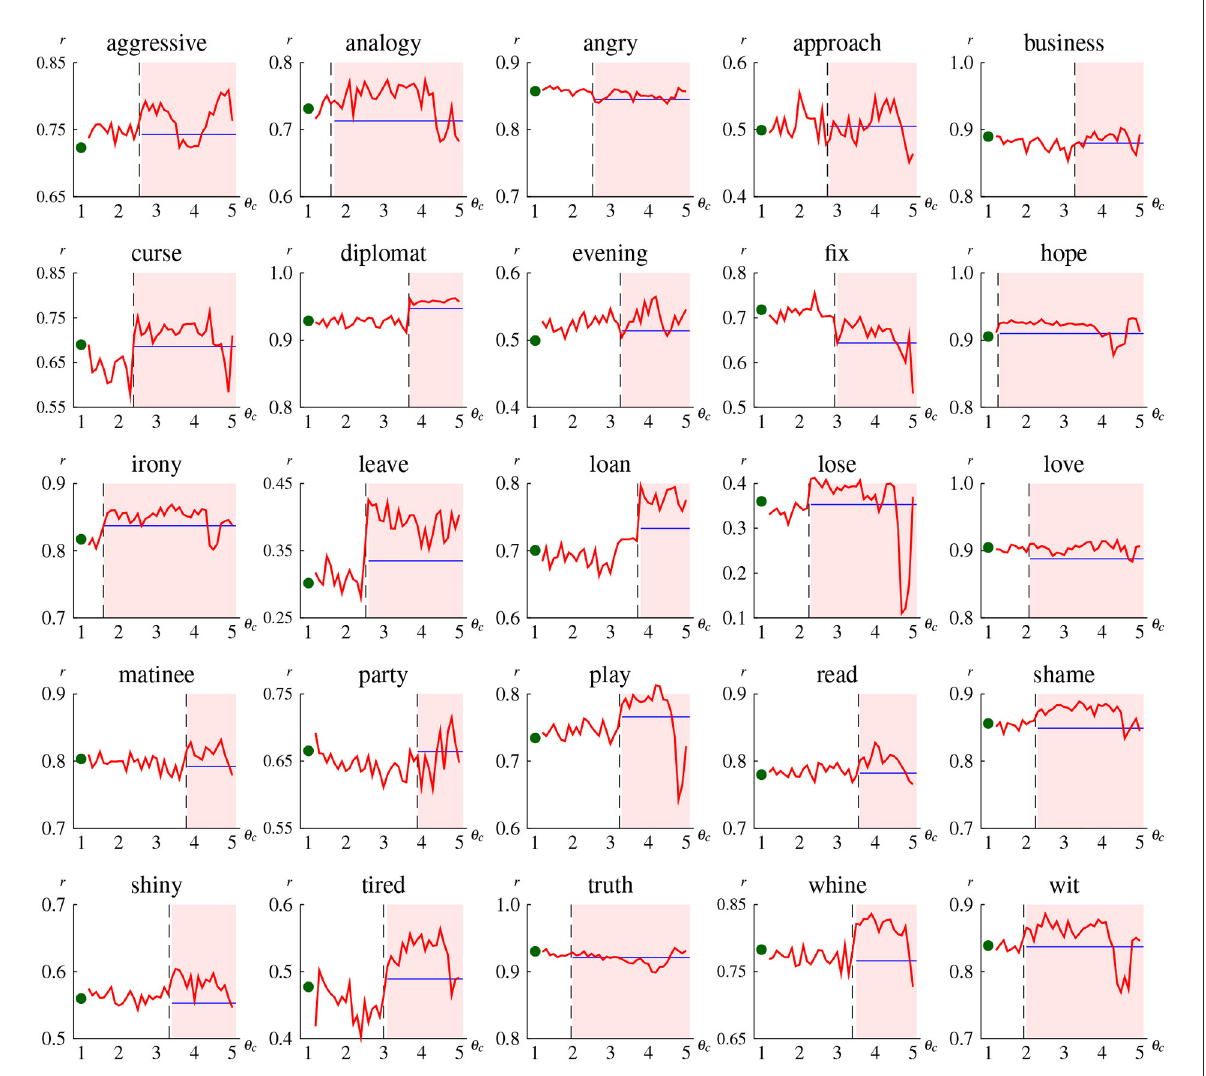
FIGURE7 Correlation coefficient of the indirect grounding model DSM I for some individual abstract concepts as a function of concreteness threshold θ c . The plot at θ c = 1.0 denotes the correlation of the hybrid (i.e., direct grounding) model DSM H (because DSM I with θ c = 1.0 is identical to DSM H ). The blue horizontal line is drawn at the correlation coefficient of the textual model DSM T . The dashed vertical line denotes the word concreteness, and thus the line chart in the red shaded area represents the correlation obtained using indirect visual